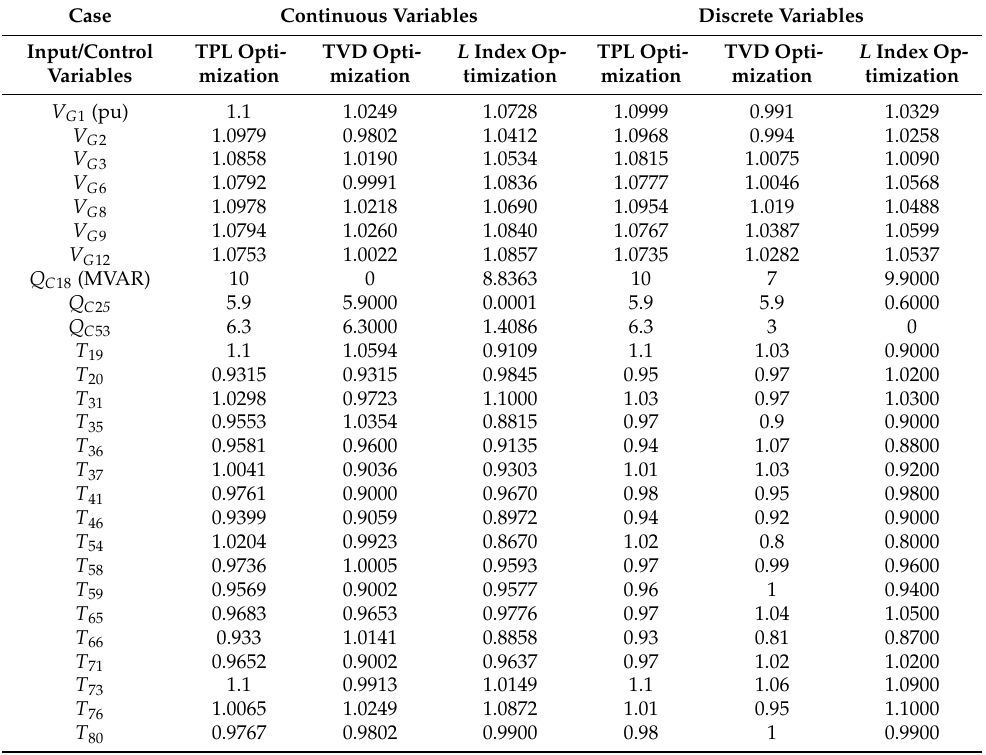
Table A2. Optimal solutions obtained by ICOA for the IEEE 57-bus system.